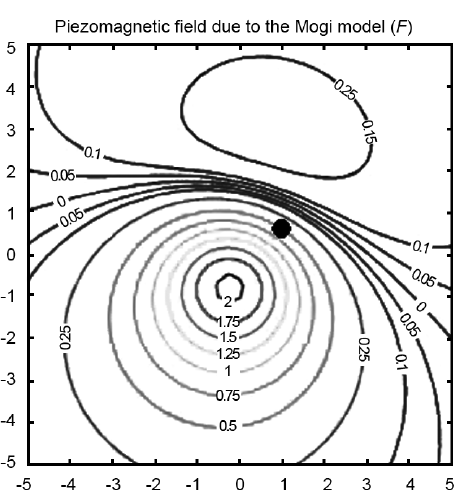
Fig. 3. Total intensity changes on the ground (2.5 m above the surface) due to the Mogi model. Unit in nT. This area shows 10 km × 10 km square of which center is right above the pressure source. A solid cir- cle indicates the horizontal position of a borehole (2 km north and 1 km east from the